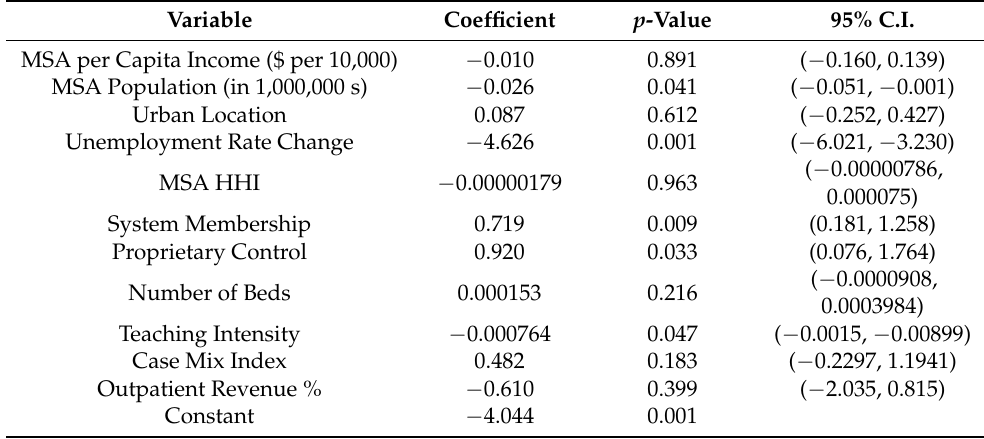
Table 4. Regression Model Results for Study Aim 2: Return on Assets (Dependent